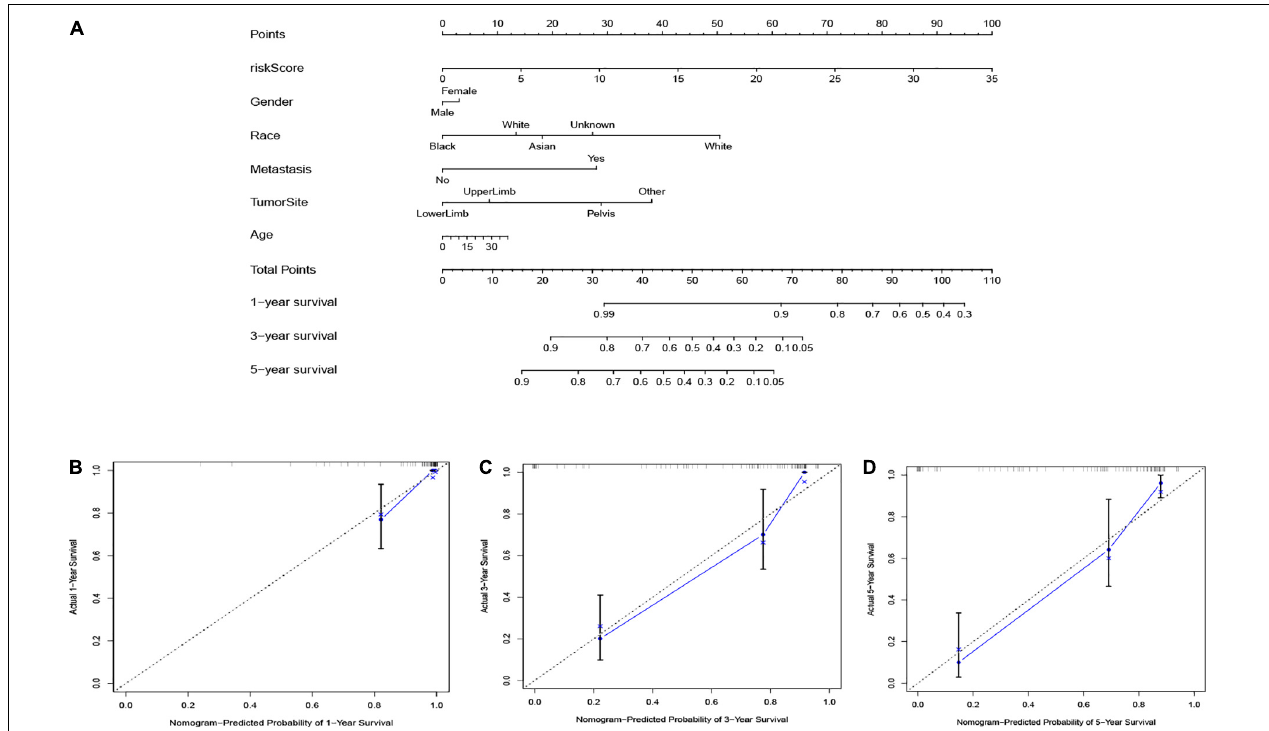
FIGURE 8 | (A) The nomogram based on the TARGET database. The calibration curves were applied to predict the 1- (B) , 3- (C) , and 5-year (D) survival in the TARGET cohort.